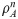
Stored sensory-motor mappings and sensory characterizations of phonemes under normal conditions.Left panels: auditory-motor internal mapping ρAn (top) and somatosensory-motor internal mapping ρSn (bottom). Both mappings are assumed to be identity. Right panels: auditory (top) and somatosensory (bottom) characterization of phonemes. Probability distributions are all Gaussian, evenly distributed in each space, and with equal standard-deviations, equal to 18 of the distance between phonemes.